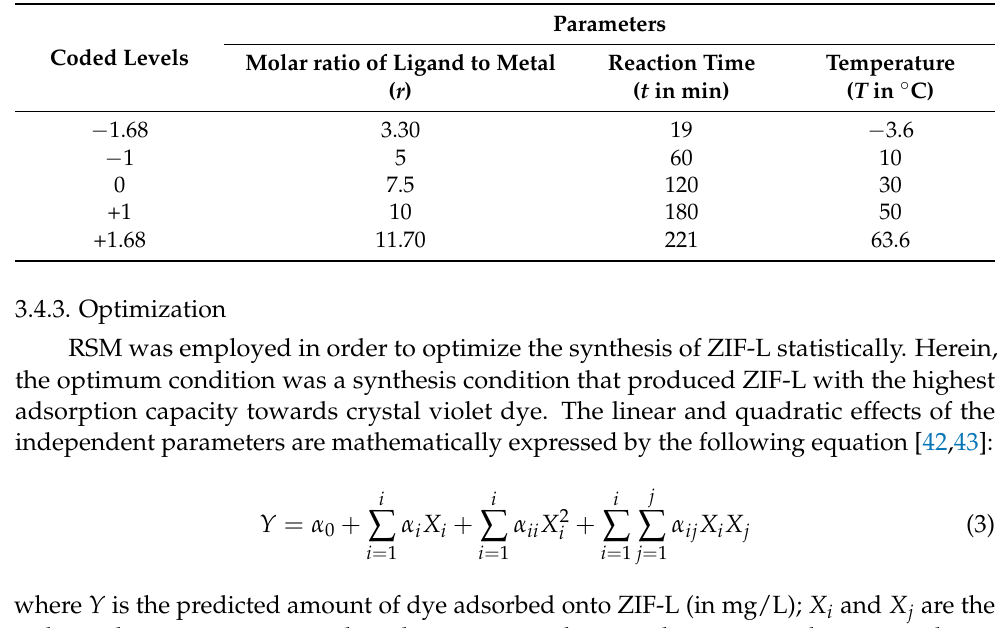
Table 5. Uncoded and coded levels of the independent